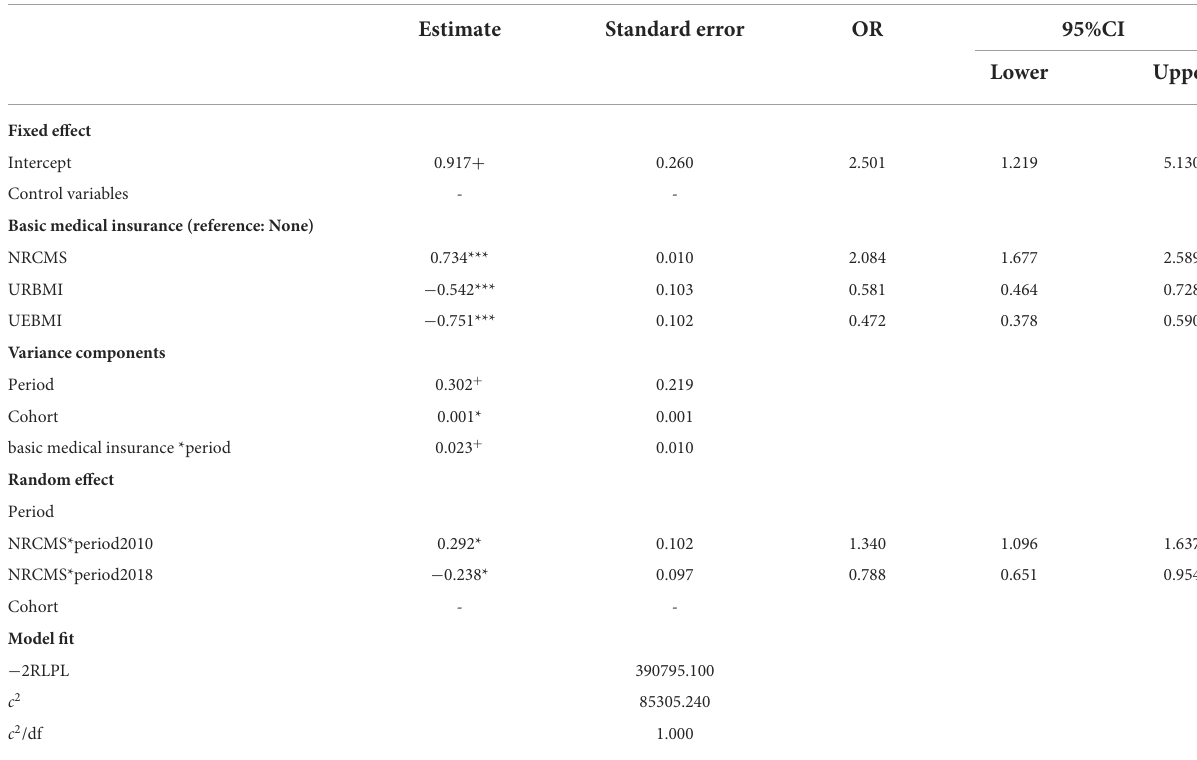
TABLE 3 The effect of basic medical insurance participation on primary care with